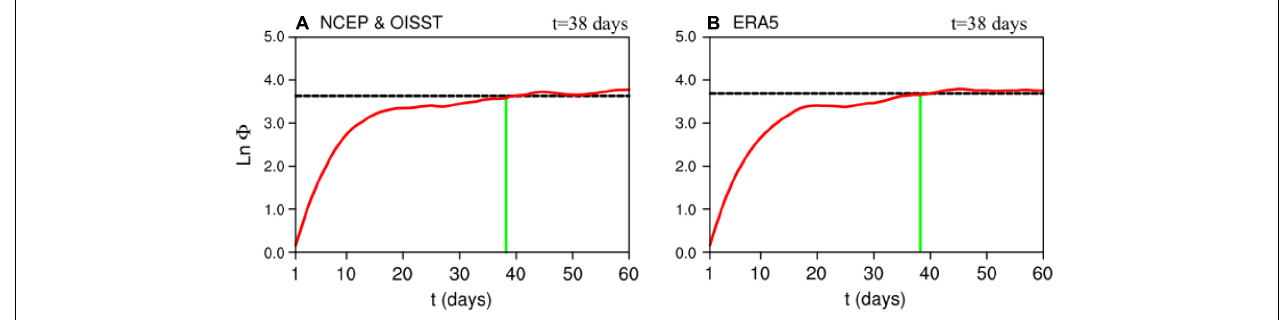
FIGURE 7 | (A) Spatial distribution of the predictability limits of intraseasonal SST during boreal summer from 1998 to 2014. (B,C) Are the same as (A) , but for intraseasonal U850 and intraseasonal OLR. (D) Ratio between the intraseasonal variance and the total variance of SST during boreal summer from 1998 to 2014. The superimposed contours are the SST mode of the positive CIO mode (same as the color shades in Figure 4B ). (E,F) Are the same as (D) , but for U850 and OLR. The contours in (E) are the U850 mode of the positive CIO mode (same as the contours in Figure 4B ). All the results are based on the ERA5 reanalysis.